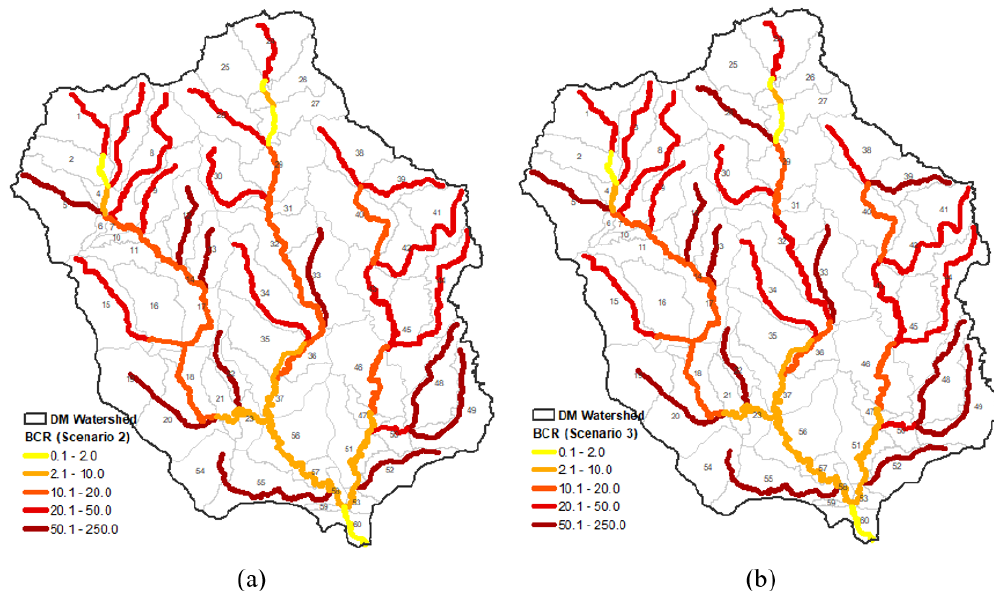
Figure 9. (a) Benefit–cost ratio map for full riparian restoration (scenario 2). (b) Benefit–cost ratio map for efficient riparian restoration (scenario 3). The reduction in the number of days that exceed 18 ◦ C was considered a riparian restoration benefit. The cost corresponds to the 2010 riparian restoration cost in millions of